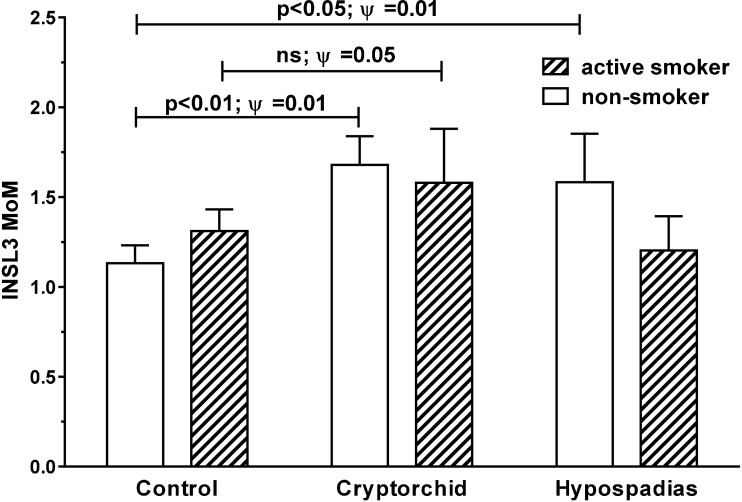
Age-corrected INSL3 MoM values for all gestational weeks combined for cases and controls, separated into active smokers (cotinine > 85 ng/ml) and non-smokers (cotinine < 25 ng/ml). Passive smokers (cotinine 25 < 85 ng/ml) were intermediate and omitted for clarity. Significant differences between means were only evident amongst non-smokers. Ψ Represents significance for Levene’s test for differences in variance. ns, not significant.